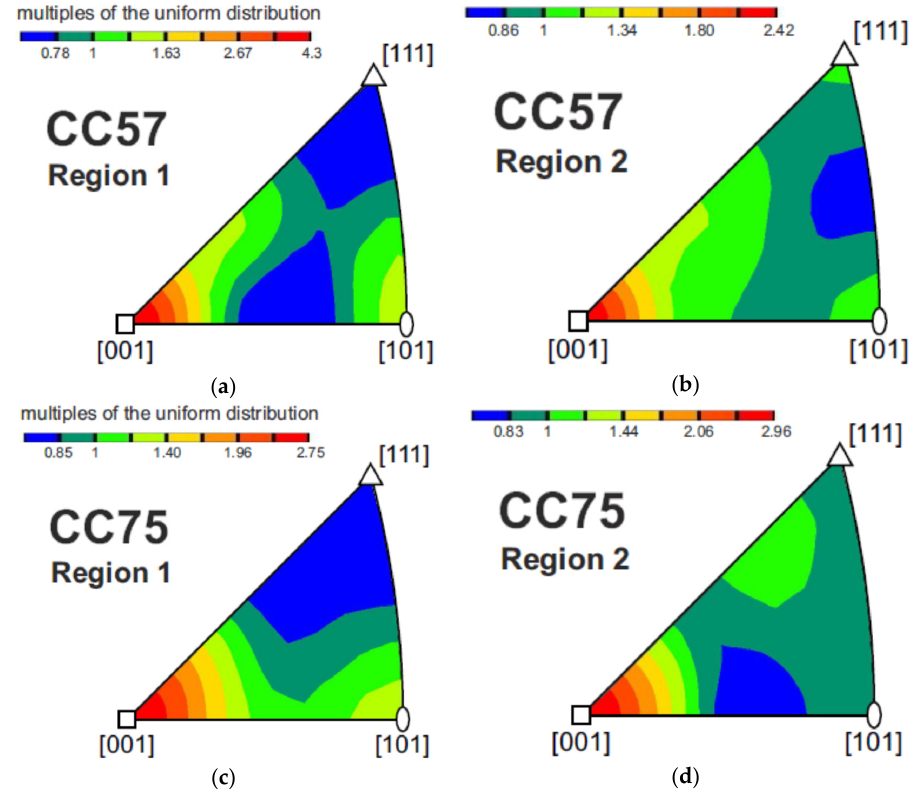
Figure 3. Orientation distribution functions within the standard triangle for the inverse pole figure of the sample surface normal for cropped EBSD (electron backscatter diffraction) maps from R1 and R2 (Figure 3a,c and Figure 3b,d, respectively) in CC57 and CC75 (Figure 3a,b and Figure 3c,d, respectively).